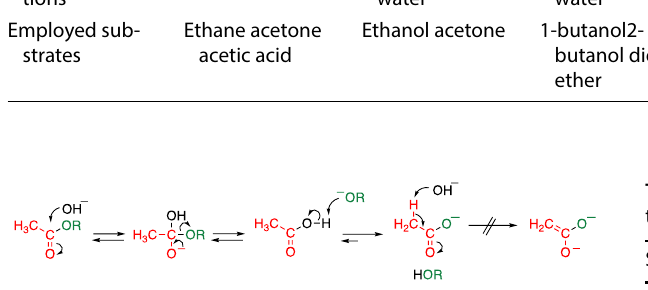
Scheme 2 Base-catalyzed hydrolysis of an ester functionality